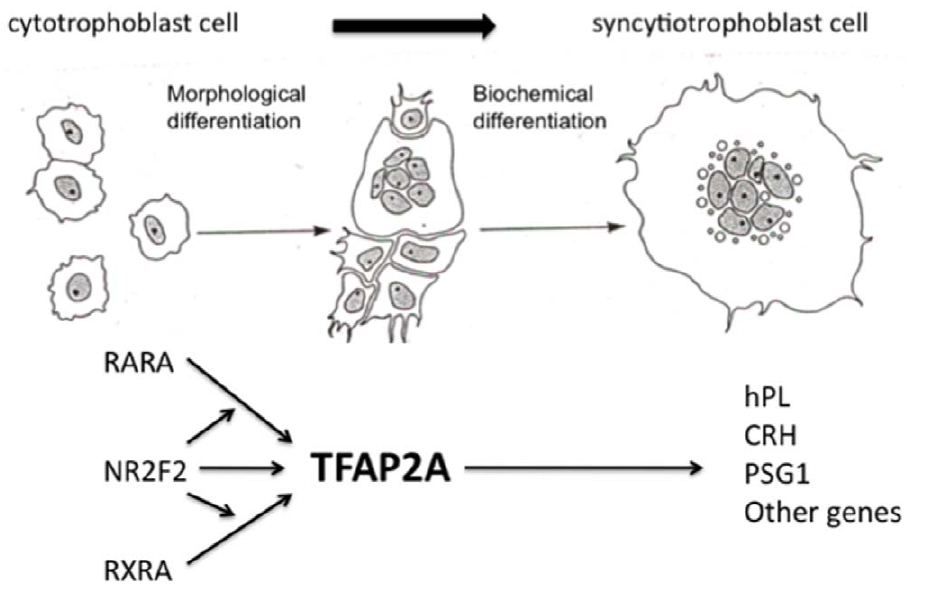
Figure 8. Schematic representation for the role of NR2F2 in the differentiation of human villous CTB cells to a STB cell phenotype. NR2F2 transactivates the TFAP2A promoter and potentiates the transactivation of the promoter by RARA and RXRA. Activation of TFAP2A in turn modulates the expression of downstream genes involved in terminal STB cell differentiation.